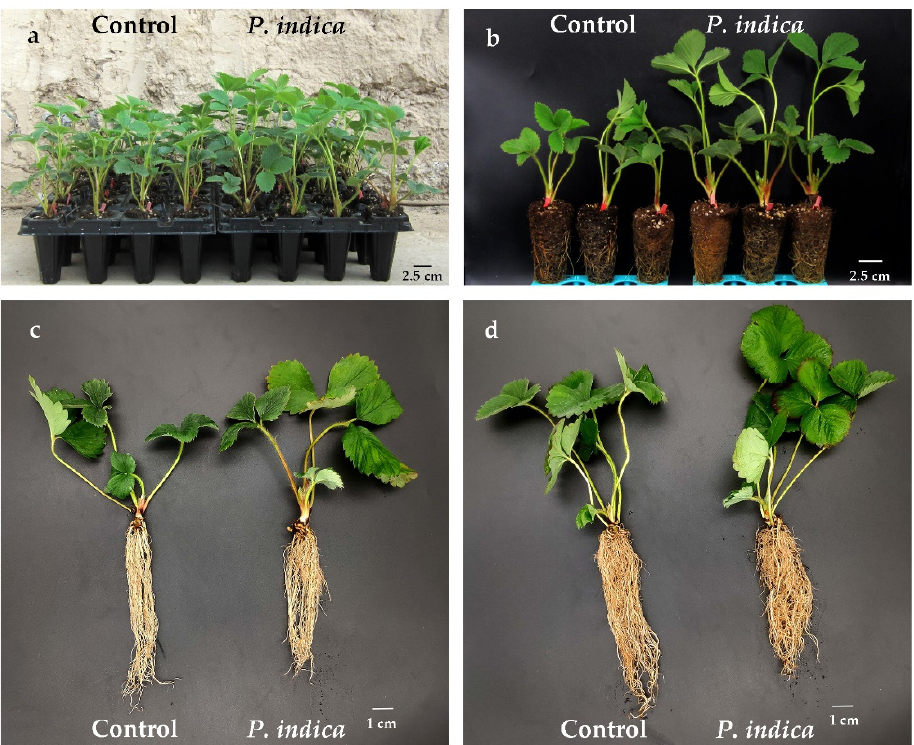
Figure 2. Typical phenotypes of P. indica colonized and noncolonized control strawberry daughter plants at 50 days post P. indica inoculation. ( a , b ) Typical phenotypes of ‘Benihoppe’ daughter plants; ( c ) P. indica colonized and noncolonized control ‘Benihoppe’ daughter plants; ( d ) P. indica colonized and noncolonized control ‘Sweet Charlie’ daughter plants.